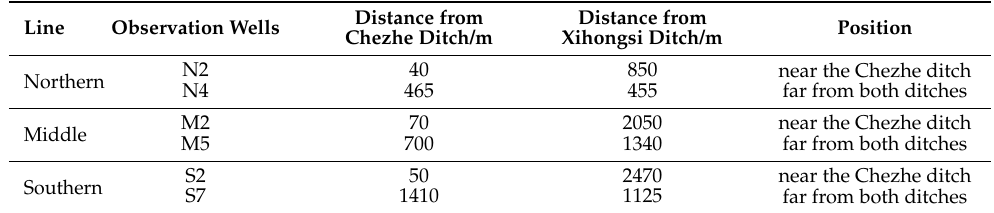
Table 5. Distance between representative observation wells near the ditch and far from the ditch and the main drainage ditches in the northern, middle and southern